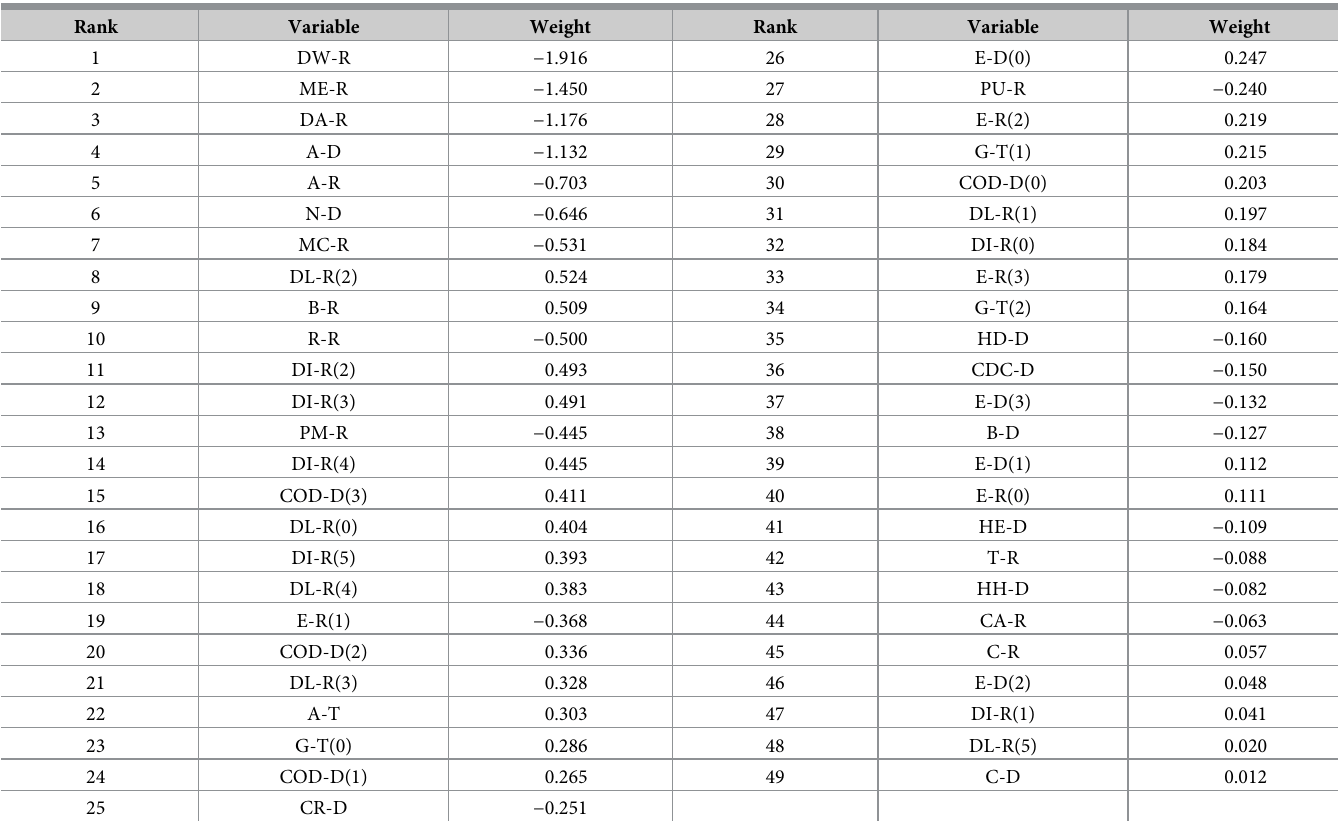
Table 5. Best LR model weights per variable (graft-survival prediction at 5-years). The variables are ranked according to the coefficient absolute value.